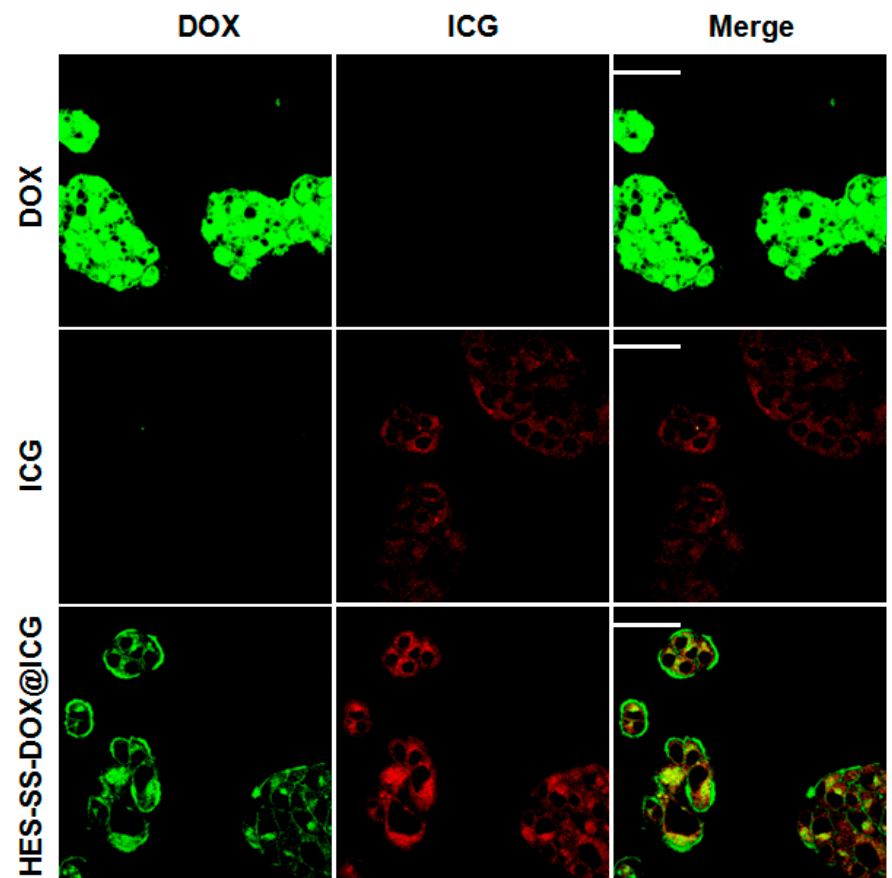
Figure 3. Subcellular localization of free DOX, free ICG, and HES-SS-DOX@ICG NPs in HepG2 cells after 4 hours of co-incubation (scale bar: 50 μ m).